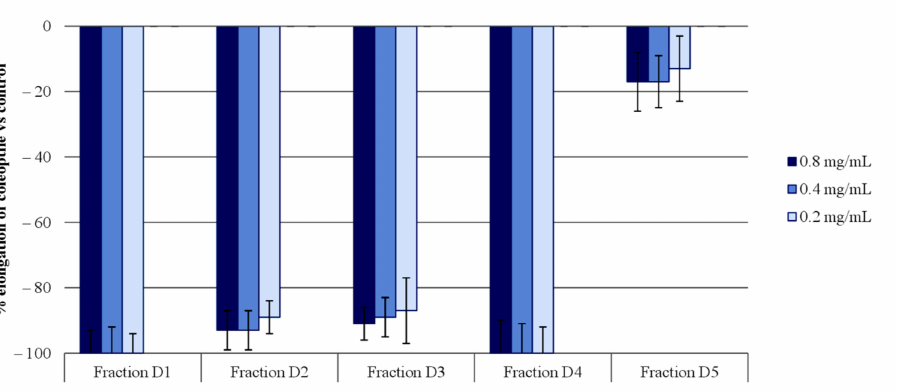
Figure 3. The bioactivities obtained in the etiolated wheat coleoptile bioassay for the subfractions obtained from fraction D of M. pulchrum leaves. Values are expressed as the percentage difference with respect to the control. Each bar is the mean ± standard